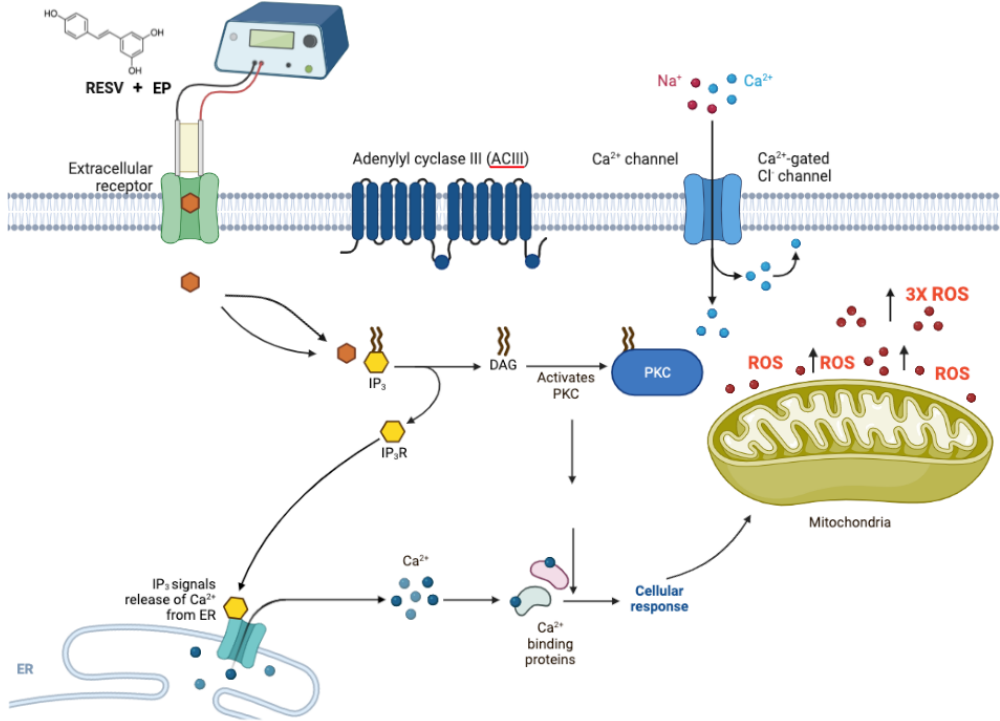
Explor Target Antitumor Ther. 2023;4:42–56 | https://doi.org/10.37349/etat.2023.00122